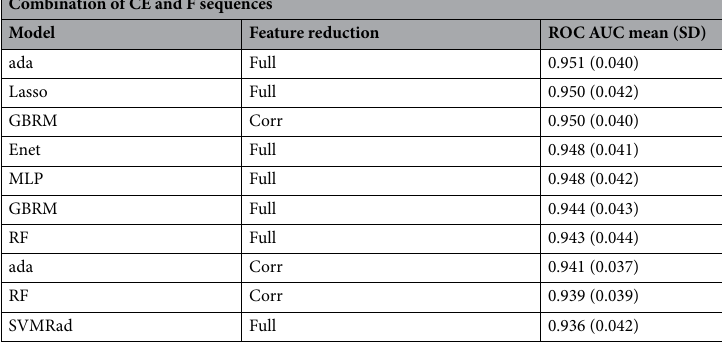
Table 3. Top ten best performing models using combination of T1-CE and FLAIR sequences ordered by ROC AUC. ada: boosting of classification trees with adaBoost; Lasso (least absolute shrinkage and selection operator; GBRM: generalized boosted regression model; Enet: elastic net; MLP: multi-layer perceptron; rf: random forest;; SVMRad: SVM with a radial kernel; full: full feature set; corr: High correlation filter; F: FLAIR; CE: T1-CE.